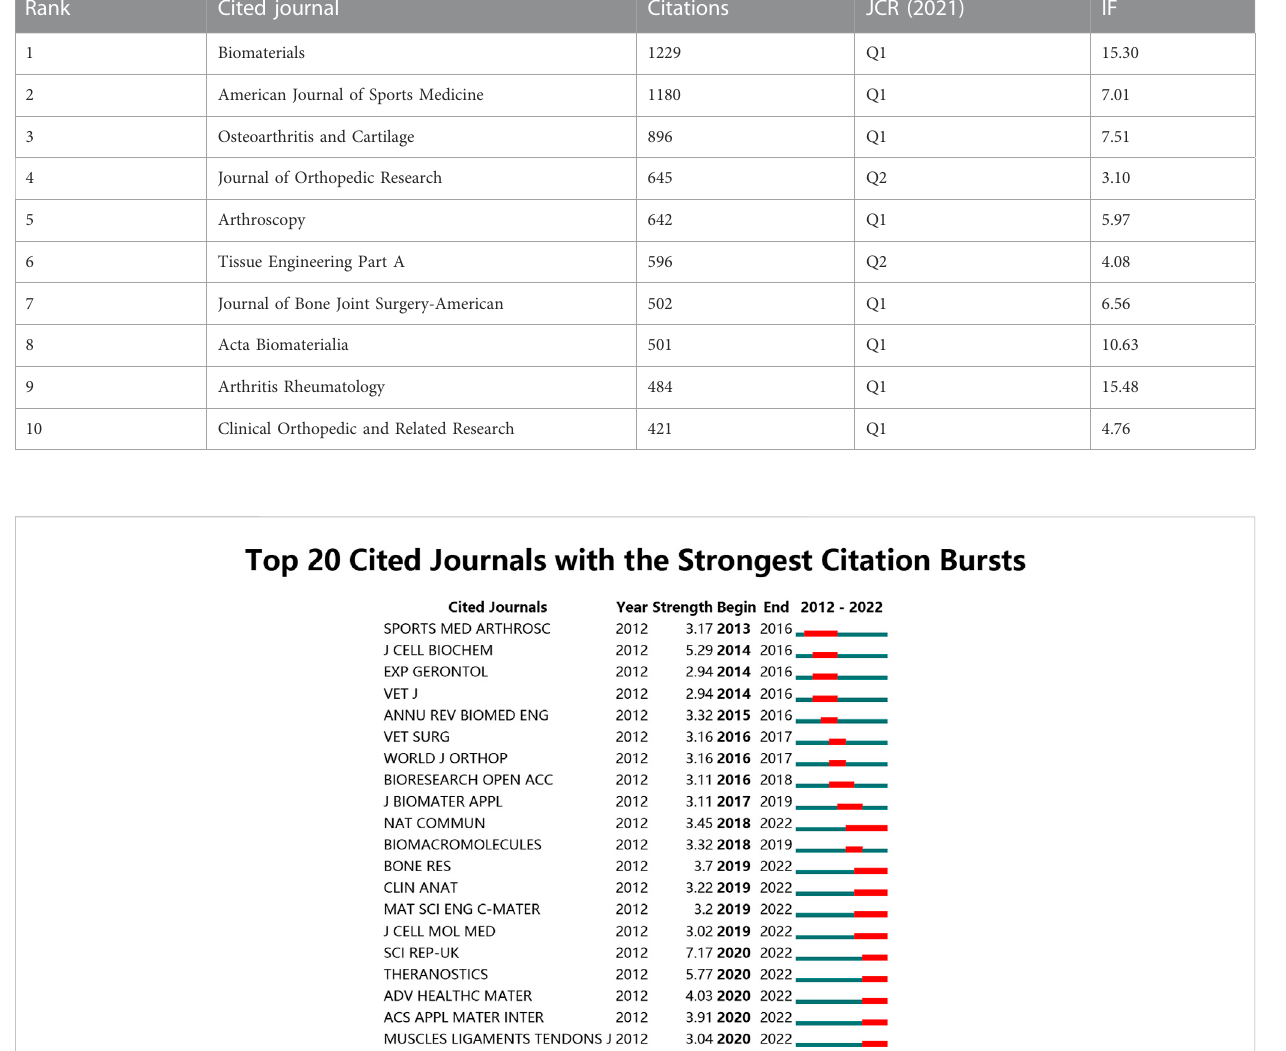
TABLE 5 The top 10 cocited journals related to stem cells for meniscal regeneration. Rank